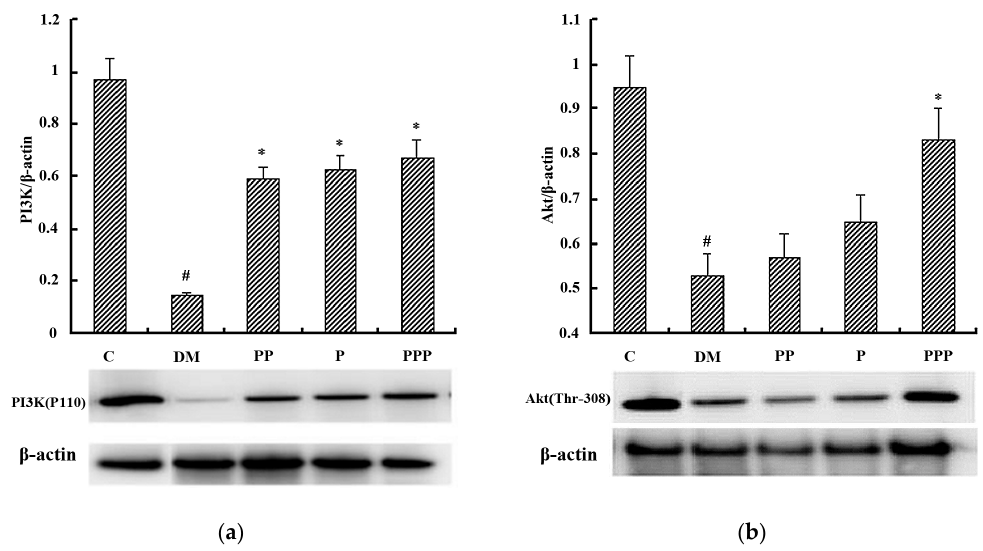
Figure 8. A Western blot analysis of the proteins that are associated with the PI3K/Akt pathway ( n = 10). ( a ) A relative density analysis of PI3K. ( b ) A relative density analysis of Akt. The relative density of PI3K and Akt is expressed as a ratio (PI3K/ β -actin, Akt/ β -actin). # p < 0.05 compared with the C group; * p < 0.05 compared with the DM group.